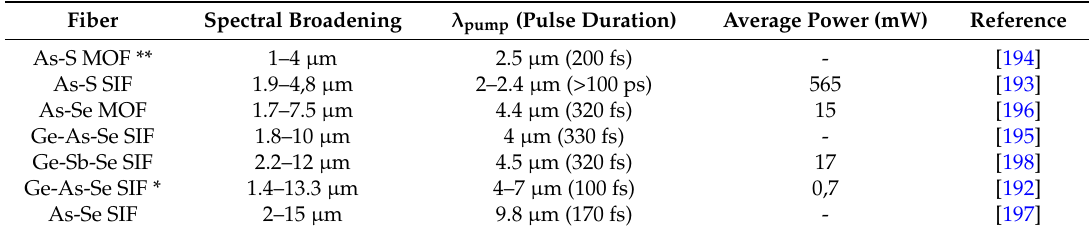
Table 2. Examples of supercontinuum broadening obtained in chalcogenide optical